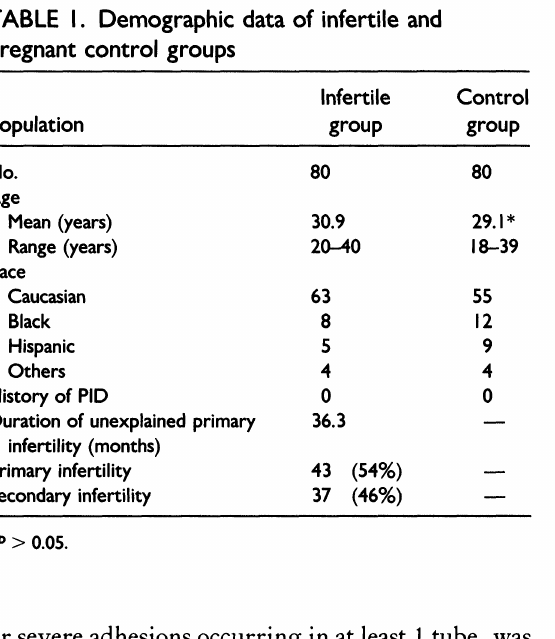
TABLE 2. Demographic data and the laparoscopic findings according to ovulation status